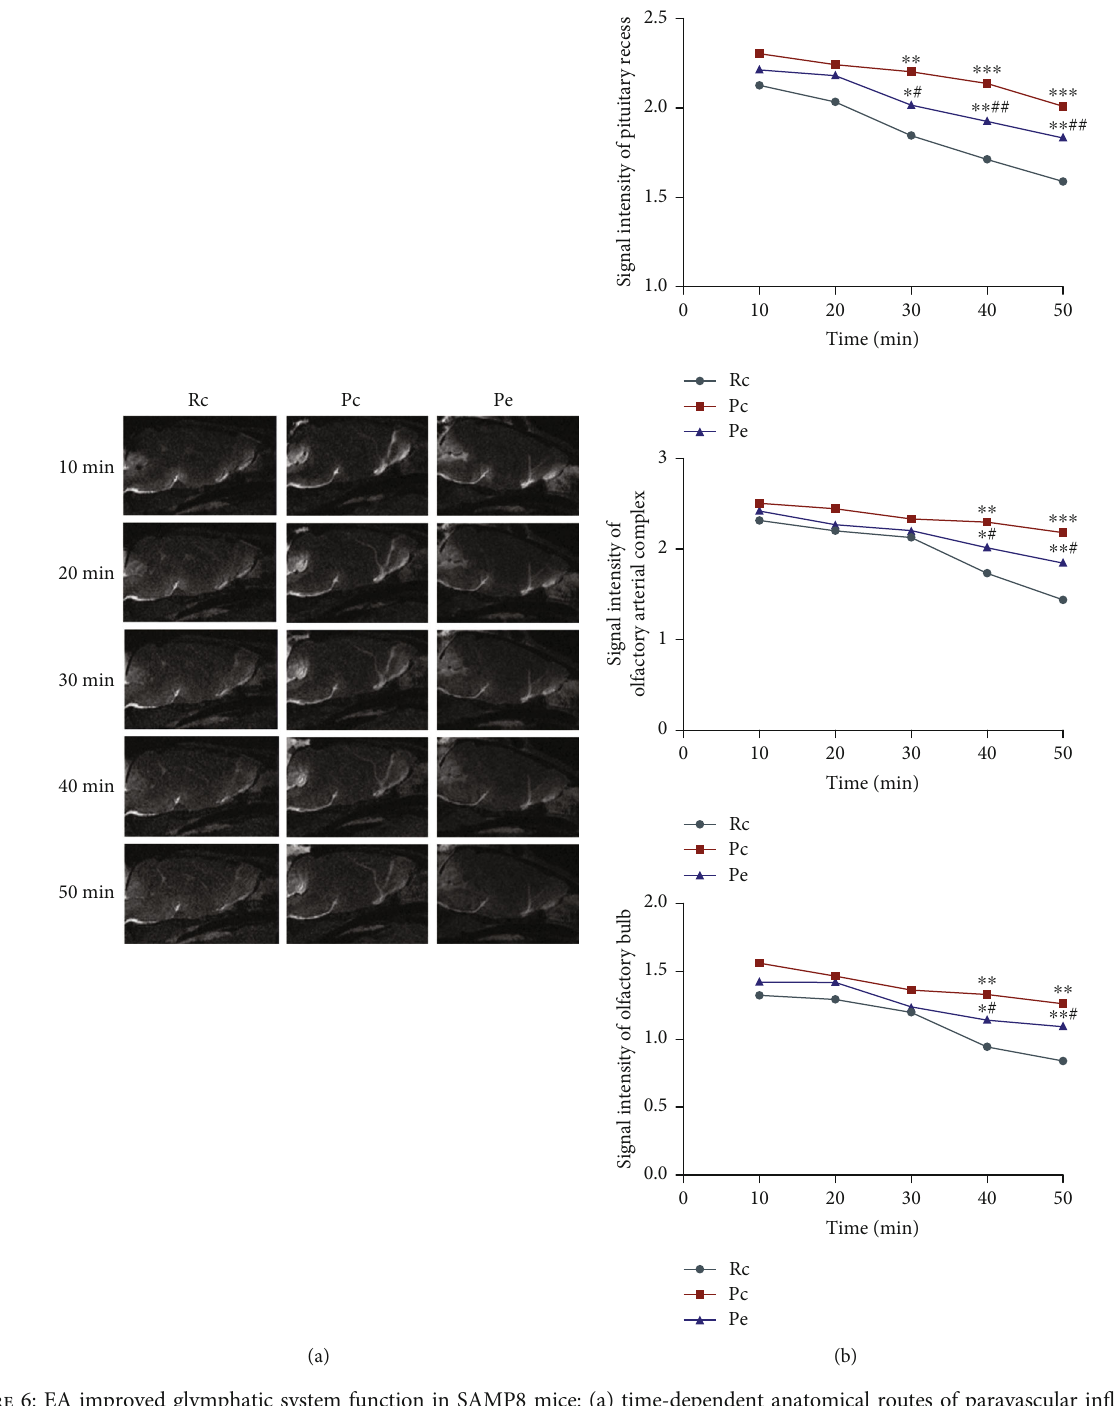
Figure 6: EA improved glymphatic system function in SAMP8 mice: (a) time-dependent anatomical routes of paravascular in fl ux in the glymphatic system; (b) signal intensity of ROIs. Data are expressed as the mean ± SD ( n = 3 in each group). ∗ P < 0 : 05 , ∗∗ P < 0 : 01 , and ∗∗∗ P < 0 : 001 versus the Rc group; # P < 0 : 05 and ## P < 0 : 01 versus the Pc